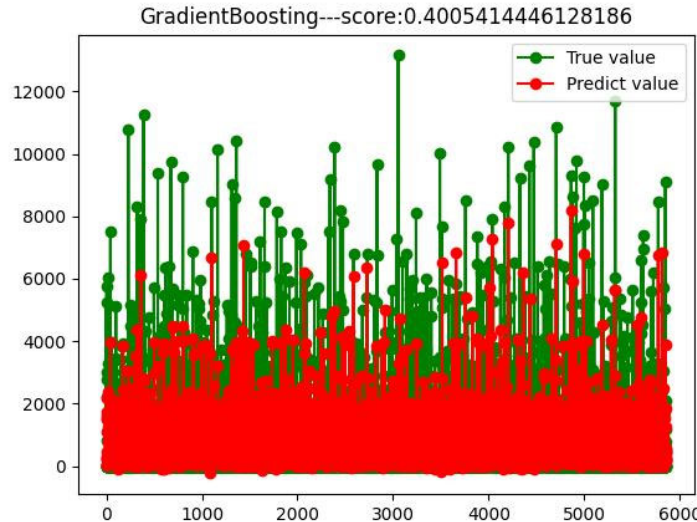
Figure A1. Prediction results of the GBDT model. Table A1. OLS Regression Results.